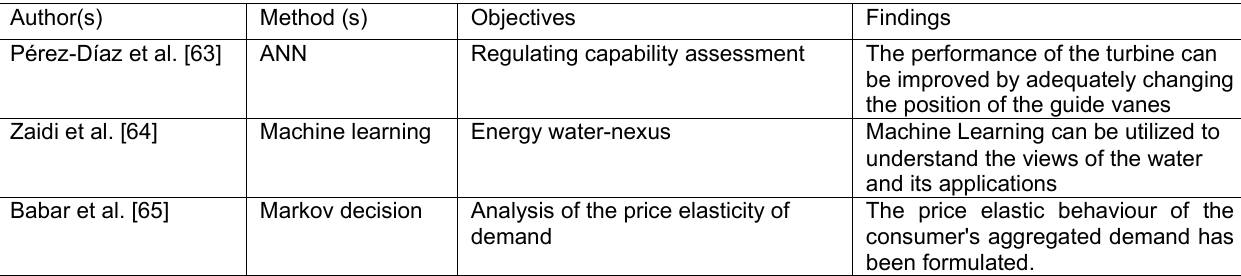
Table 7. Summary of the application of AI for accuracy evaluation and capability